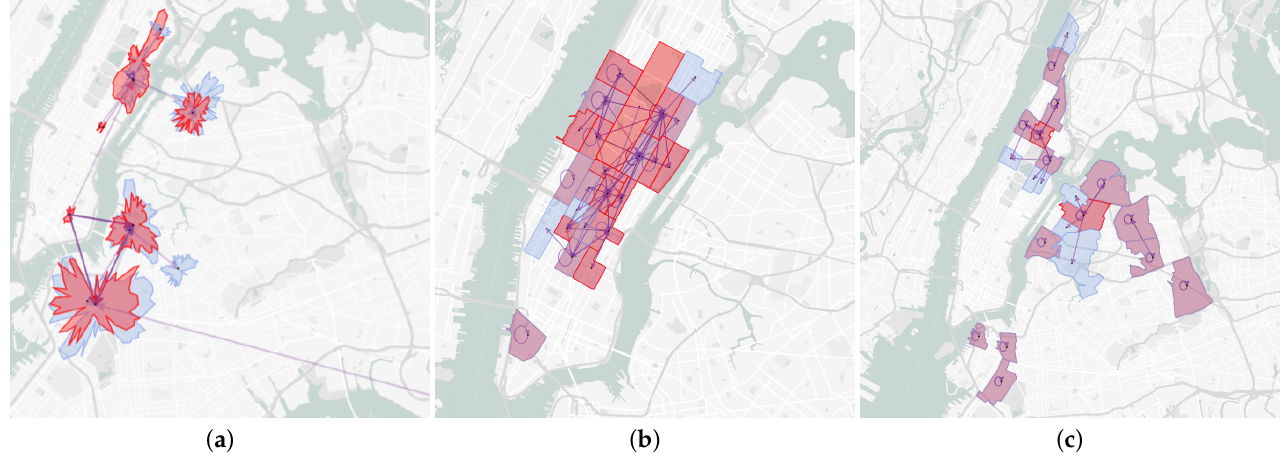
Figure 6. Clustered flows from Yellow and Green Taxis datasets. ( a ) Yellow Taxis with geo-coordinates. ( b ) Yellow Taxis without geo-coordinates. ( c ) Green Taxis without geo-coordinates.